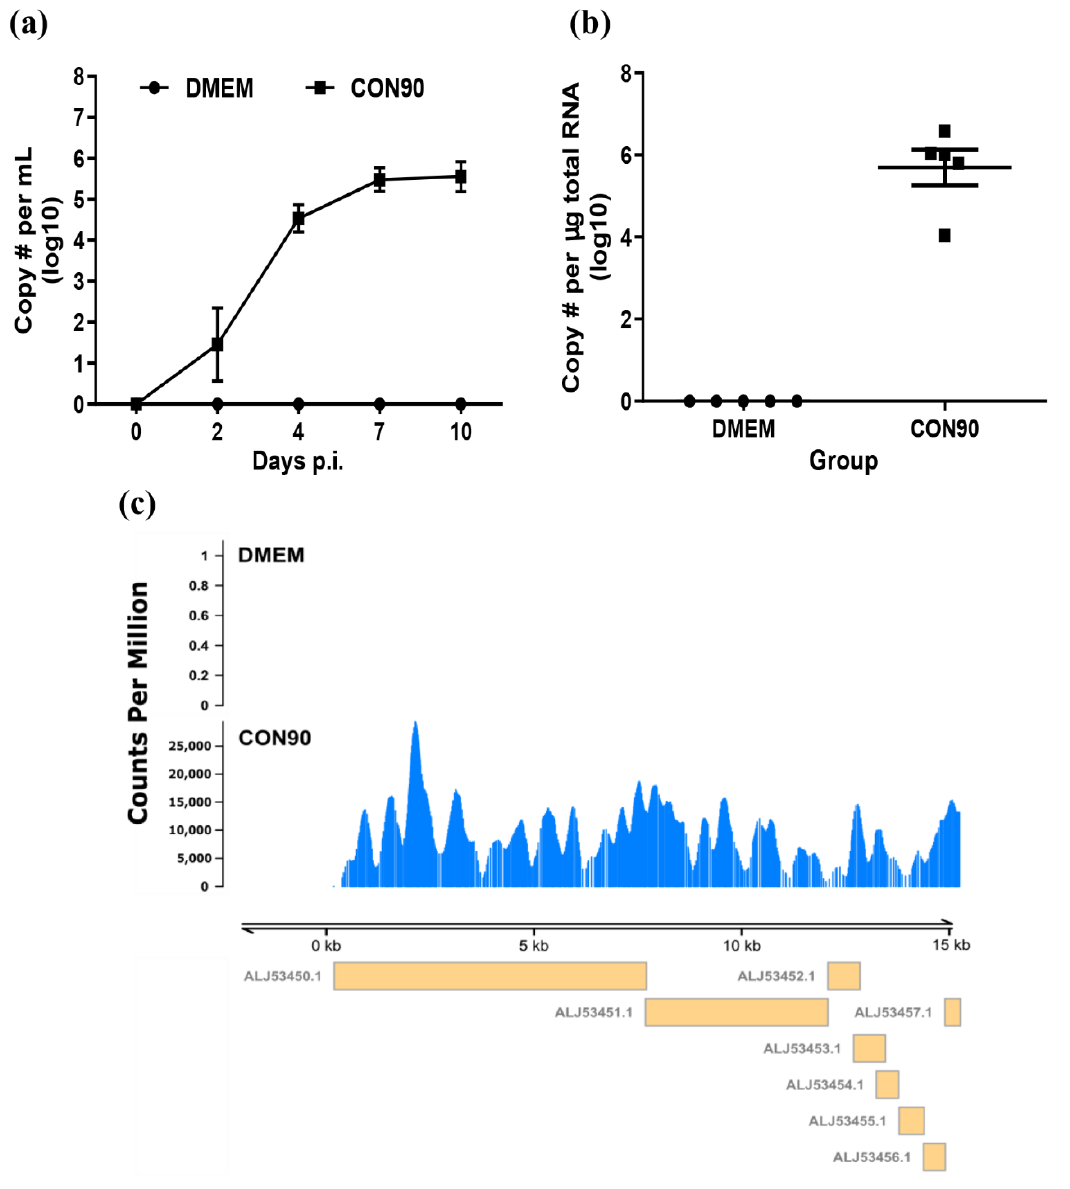
Figure 1. Post-inoculation viral RNA detection in plasma and inguinal lymph node (ILN) tissue. ( a ) Viral RNA in plasma at indicated dpi and ( b ) viral RNA level in ILN tissue at 46 dpi as determined by a commercial qRT-PCR kit (Tetracore Inc., Rockville, MD, USA). Dataset represents mean ± S.E.M values calculated from five pigs in each treatment group. ( c ) Coverage plot of the RNA reads mapped to CON90 genome. Y axis represents the count per million (cpm) while the X axis represents the viral genome. Yellow boxes under the plot with GenBank accession numbers indicate the viral open reading frames.